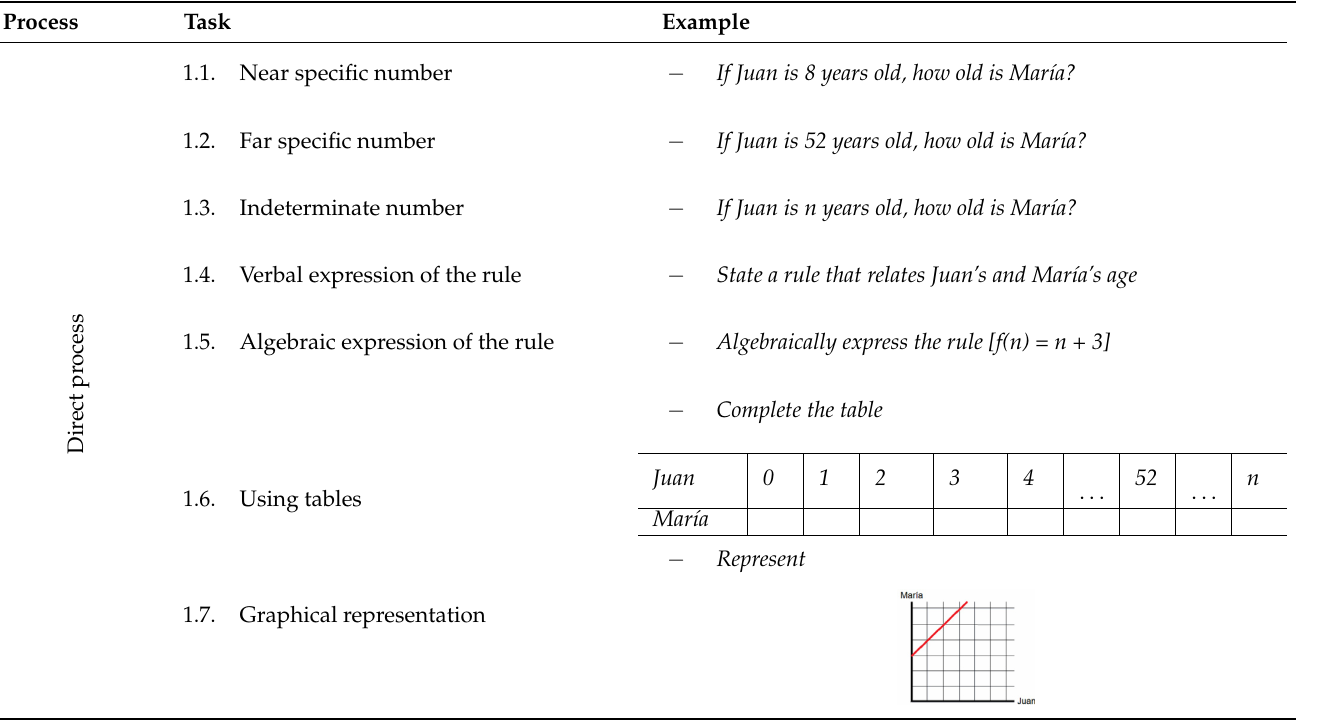
Table 6. Task sequence to promote algebraic thinking from case